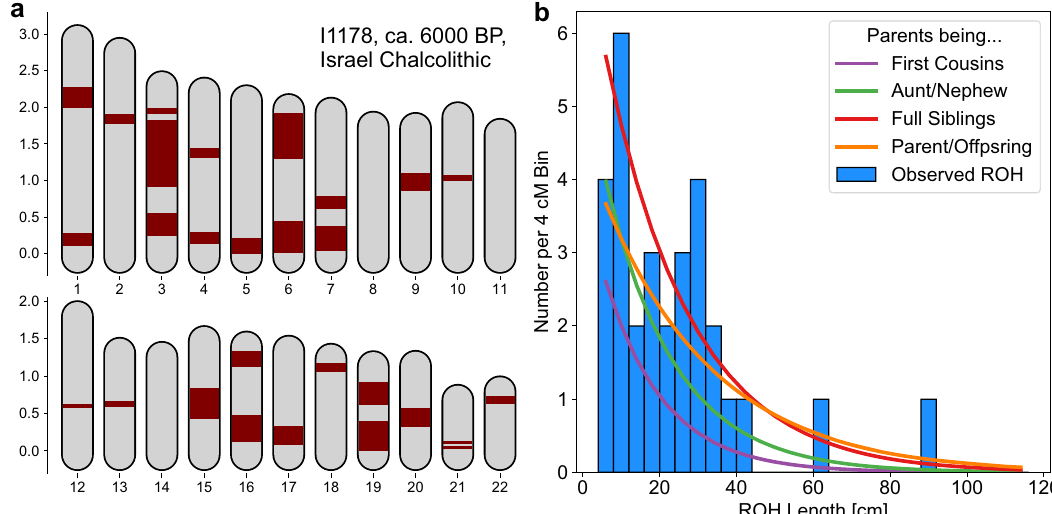
Fig. 4 ROH in a 6000-year-old individual. We show ROH of the individual with the highest sum of inferred ROH among all our samples, I1178 , a male individual context-dated to ca. 4500 – 3900 BCE, reported in ref. 30 . We inferred 703.2 cM of his genome in ROH longer than 4 cM, with the longest ROH spanning 91.1 cM. a We marked the position of these ROH on the 22 autosomes (maroon), with map length annotated in Morgan. b We depict a histogram of the ROH lengths, together with expected densities of ROH for certain degrees of parental relationships, calculated as described in Supplementary Note